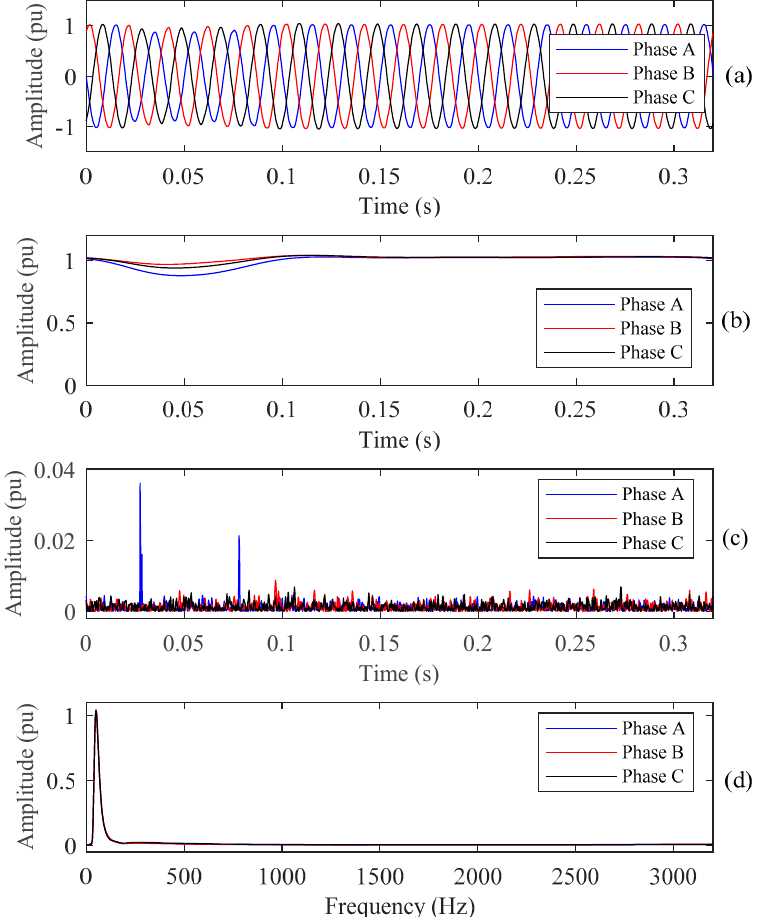
Figure 25. An actual voltage sag recorded by PQube at the University of Strathclyde on 27 June 2020 [46] and related STA : ( a ) Voltage sag; ( b ) TvA ; ( c ) TvHFA ; ( d ) FvA .